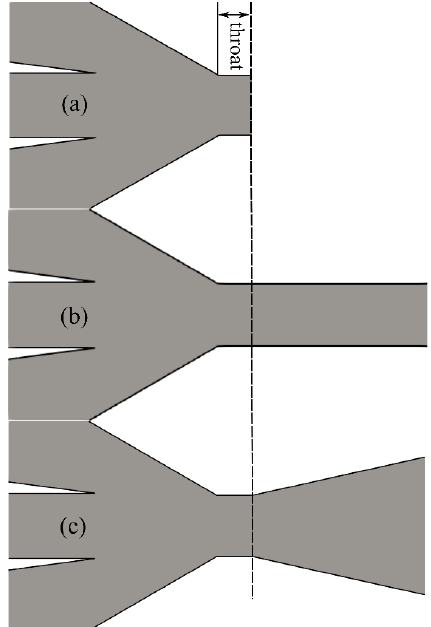
Figure 1. Scheme of different nozzle outlet orifices: ( a ) standard converging gas dynamic virtual nozzle (GDVN), ( b ) extended nozzle outlet orifice with straight channel, and ( c ) extended nozzle outlet orifice with diverging channel.